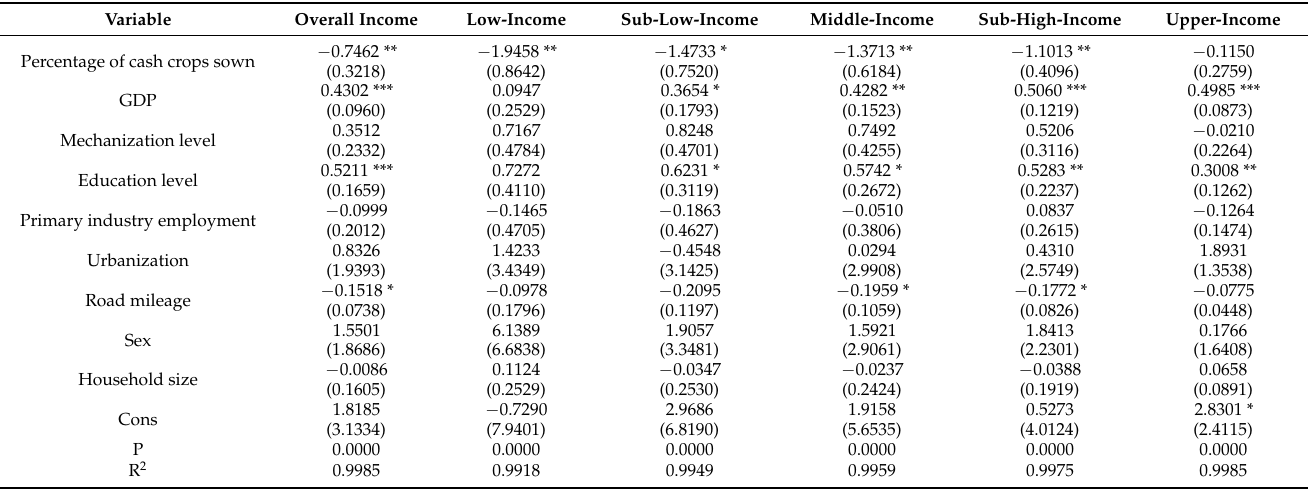
Table 6. Robustness test 3: Additional variables